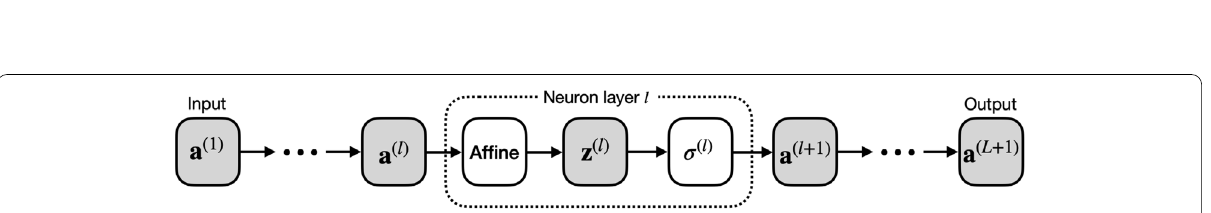
Fig. 1 Neural network training as a computational optimization process with respect to an objective function which is the error rate for classification, without loss of generality